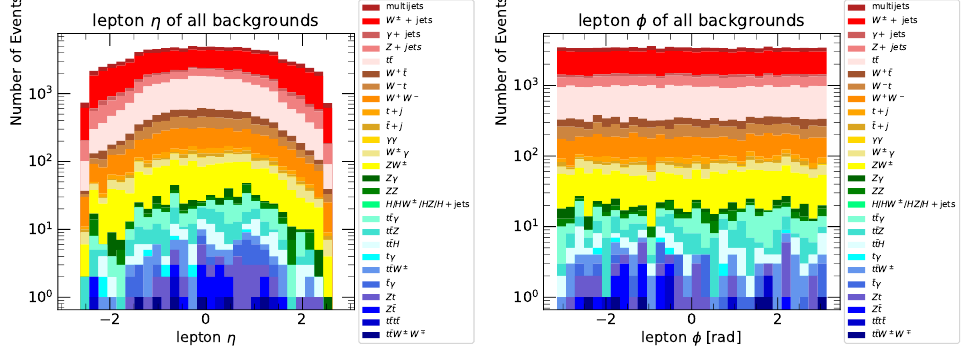
Figure 4: Transverse momentum p ( e + , e − , µ + , µ − ) for all backgrounds.